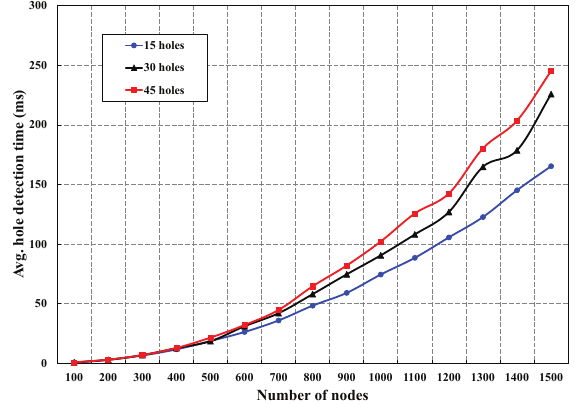
Figure 8. Average hole detection time in DCHD with different numbers of coverage